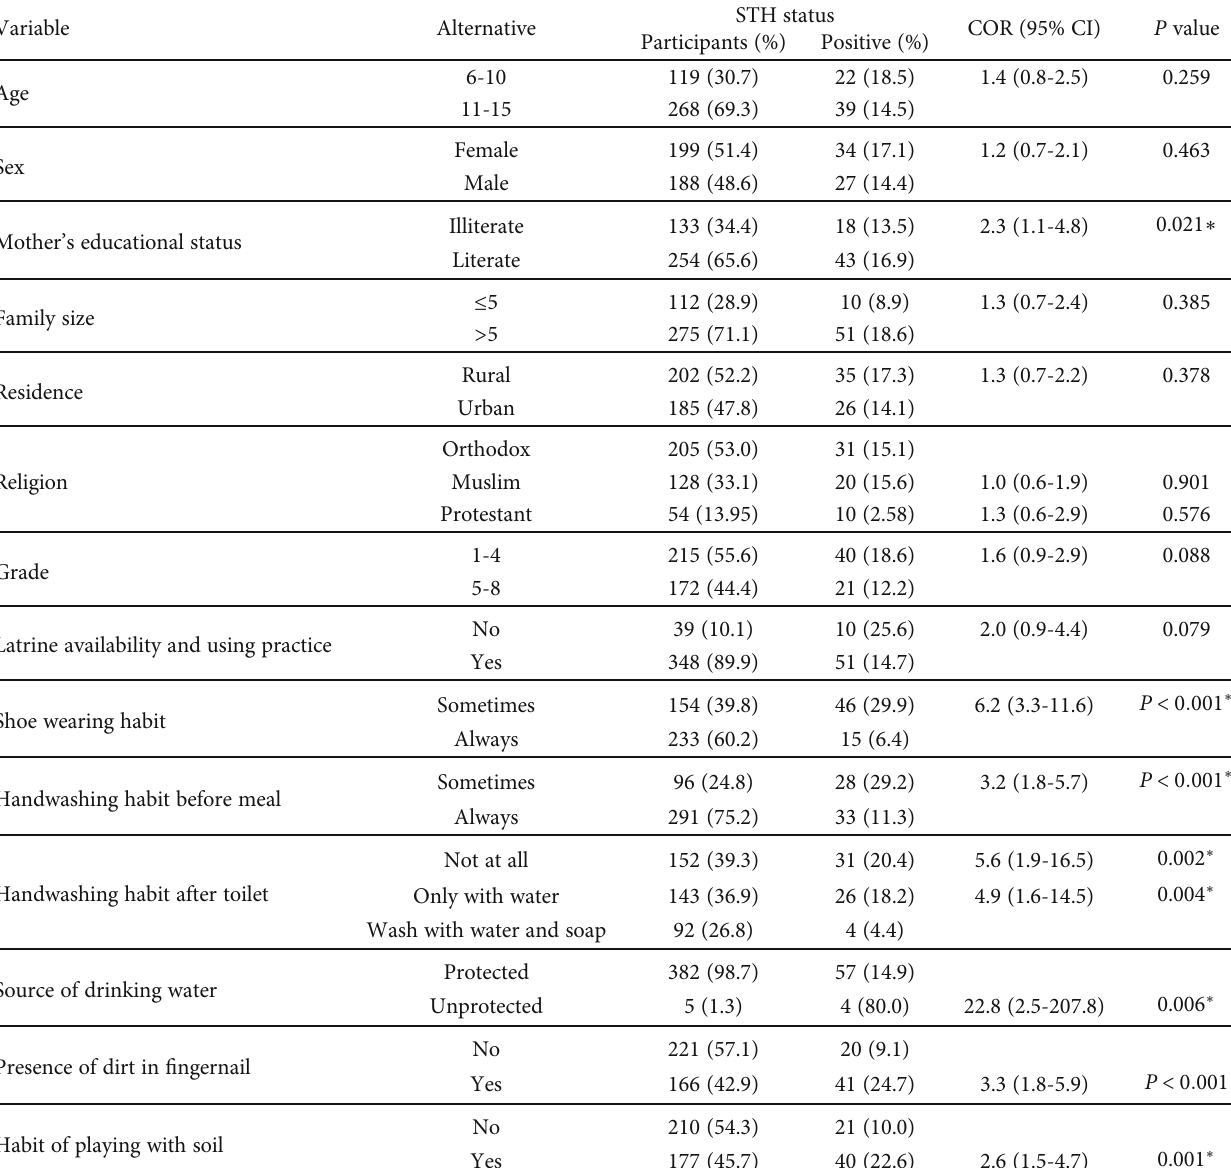
Table 2: Prevalence of STHs and individual-level associated risk factors among school-age children at Goro Elementary School, Southwest Ethiopia,